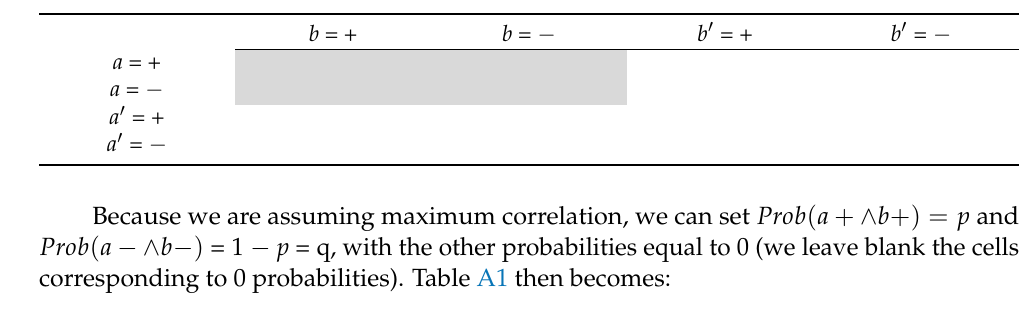
Table A2. A sequence of tables to illustrate the implications of S > 2: computating a and b .